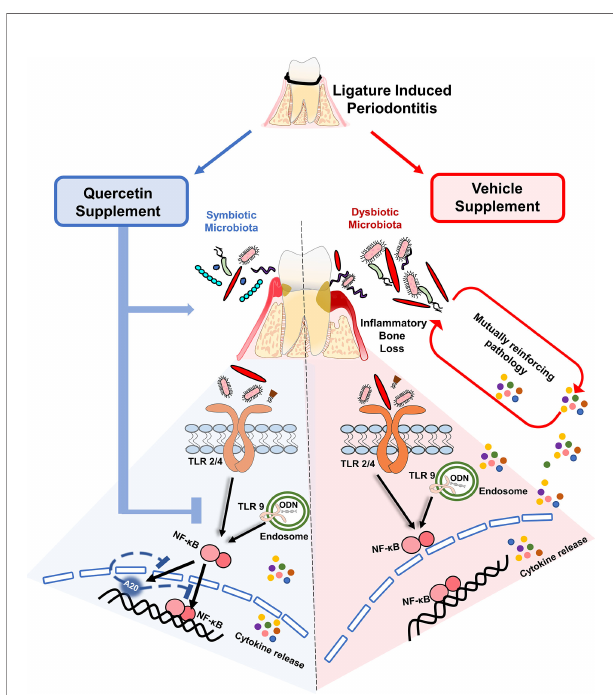
FIGURE 7 | Quercetin supplement alleviates the progression of periodontitis by aiding in the preservation of host- and microbiome-homeostasis. A self- perpetuating pathogenic cycle of deregulated in fl ammation, exacerbated cytokine release, and bacterial dysbiosis fuels tissue destruction and the subsequent development of periodontitis in response to ligature placement. Quercetin, a ubiquitous polyphenolic fl avonoid, promotes health through various biological mechanisms. Upon periodontitis induction, Quercetin supplement reduced gingival in fl ammation, alveolar bone loss and limits bacterial dysbiosis. At the cellular level, periodontal tissue homeostasis requires the stringent regulation of in fl ammatory pathways mainly driven by the activation of innate sensors, such as TLRs. Downstream of TLR activation, Quercetin supplement decreased cytokine production by regulating NF- k B activation and possibly modulating A20 expression, in response to oral bacteria and TLR agonist challenge. Collectively, the regulation of in fl ammation with Quercetin supplement has a signi fi cant impact on gingival in fl ammatory gene expression and bacterial composition that is coincident with ameliorating disease